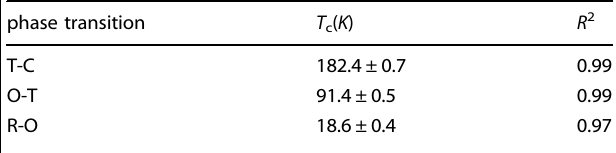
Table 1. Critical temperatures of the T-C, O-T, and R-O transition at ambient pressure. R 2 represents the coef fi cient of determination of best linear fi ts of Δ μ ( T ) across the coexistence regions, as shown in Fig. 6.